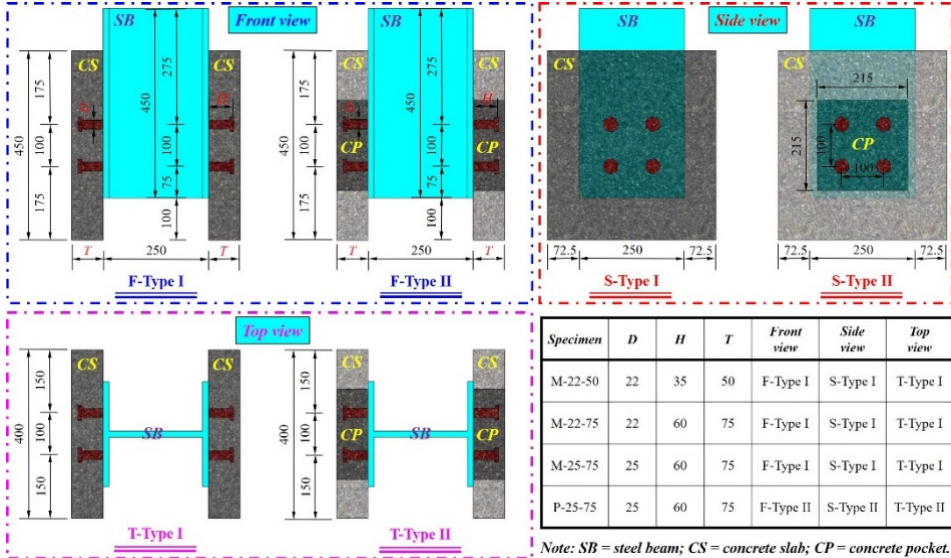
Figure 1. Details of specimens (unit: mm). As depicted in Figure 1, the designations for the specimens were determined accord- ing to the test variables. The first letter corresponds to the casting methods, including specimens with the monolithic cast (M) and precast (P) slabs. Furthermore, two different stud diameters (22 and 25 mm) and slab thicknesses (50 and 75 mm) were chosen for this study. Particularly, all the specimens maintained an identical concrete cover thickness of 15 mm. As a result, three different stud aspect ratios were adopted in this study, that